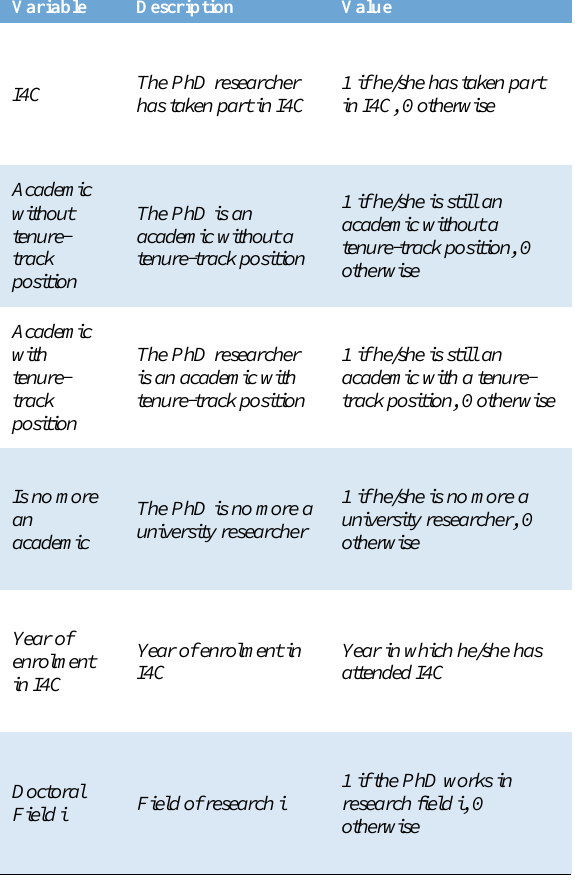
Table 4. Independent and control